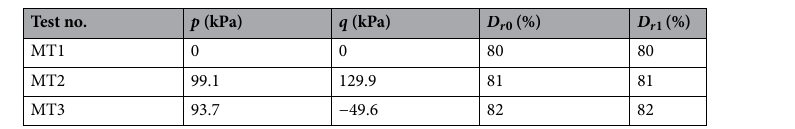
Table 2. Testing program with samples prepared by moist tamping (MT). MT1 as reference test. MT2 with undrained preshearing in triaxial compression and MT3 in triaxial extension.